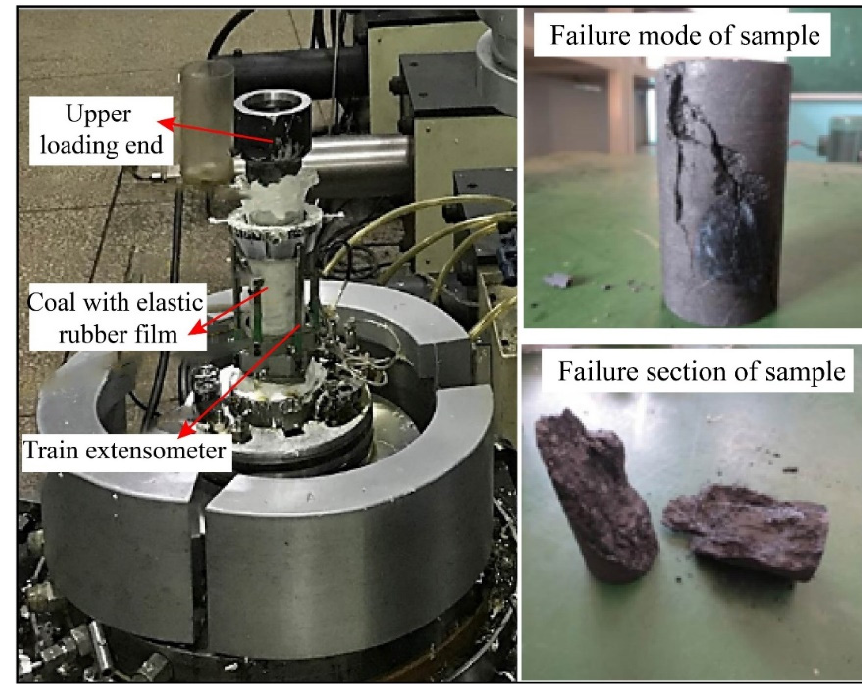
Figure 6. Failure modes of coal samples in triaxial rheological test.